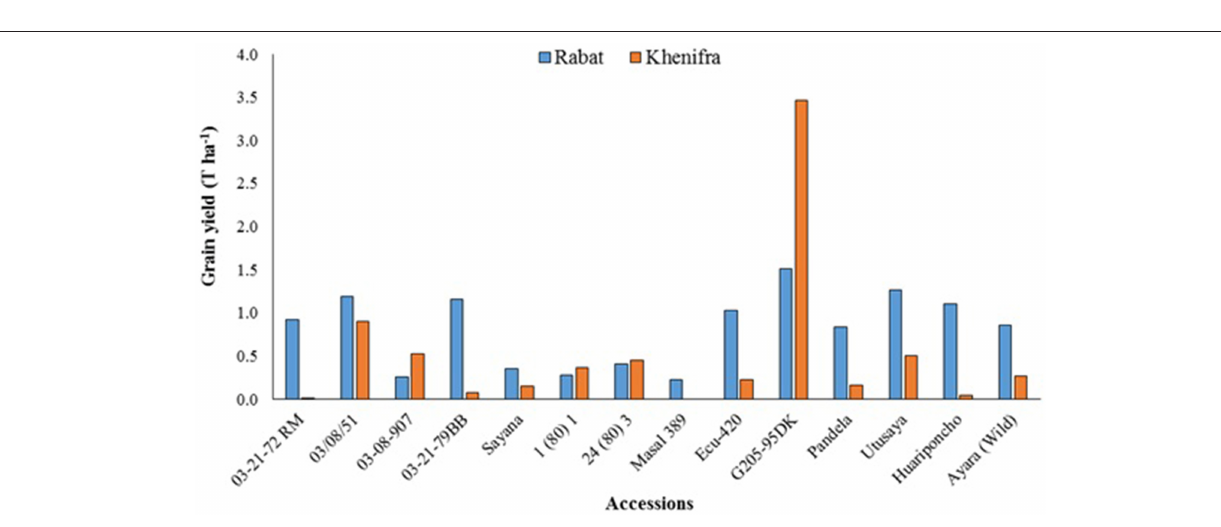
FIGURE 3 | Quinoa grain yields (T ha − 1 ) under high altitude (Khenifra) and coastal (Rabat) conditions in 2000-01 season (Benlhabib et al.,